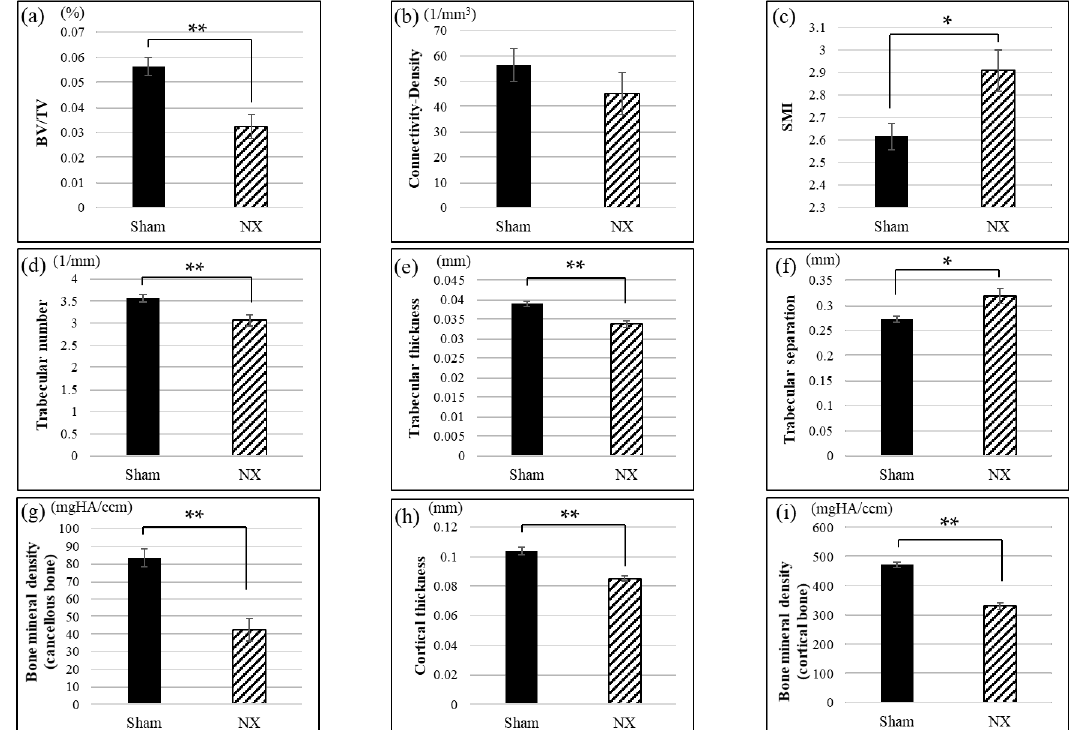
Figure 6. Micro-CT parameters. Relative to the Sham group, the NX group demonstrated an altered ( a ) bone volume (BV/TV), ( b ) connectivity density, ( c ) structural model index (SMI), ( d ) trabecular number, ( e ) trabecular thickness, ( f ) trabecular separation, ( g ) cancellous BMD, ( h ) cortical thickness, and ( i ) cortical BMD. * p < 0.05, ** p < 0.01.